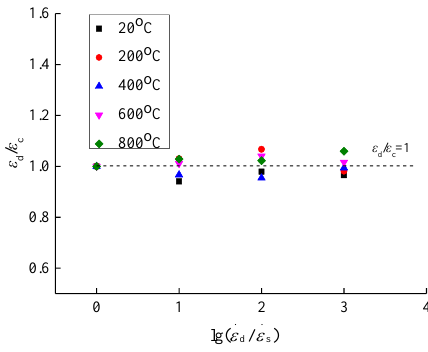
Figure 16. Change factor of peak strain.